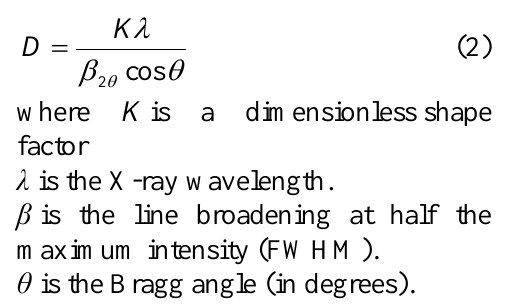
Fig. 2: Plot of (αhν) 2 versus (hν) curve of In at 400 ° C.